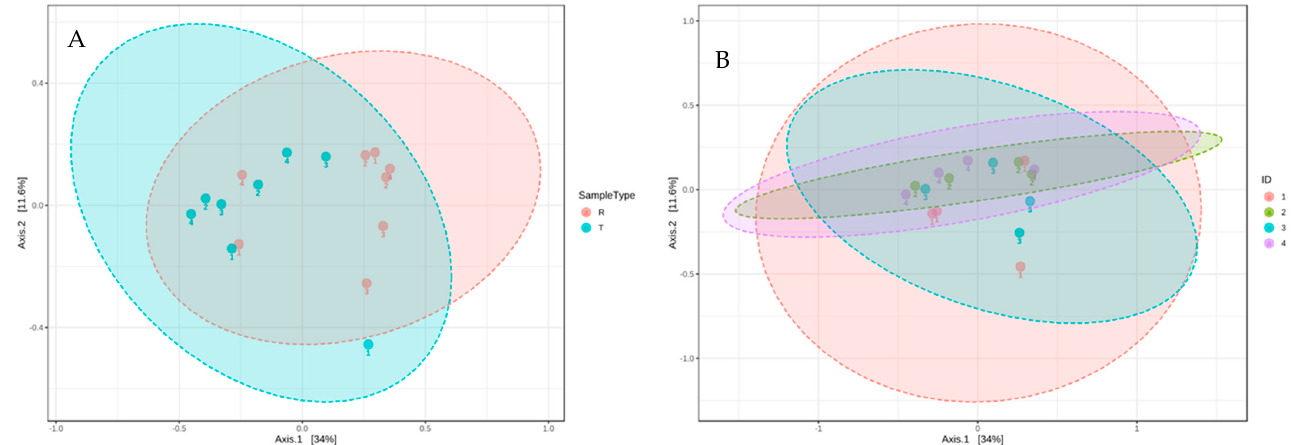
Figure 4. PCoA 2-D plot using bray distance and the explained variances are shown in brackets. R indicates raw greywater and T indicates treated greywater. ID 1,2,3,4 corresponds to CW1, CW2, CW3, CW4, respectively. ( a ) Community analysis of raw and treated samples. ( b ) Community analysis by household.